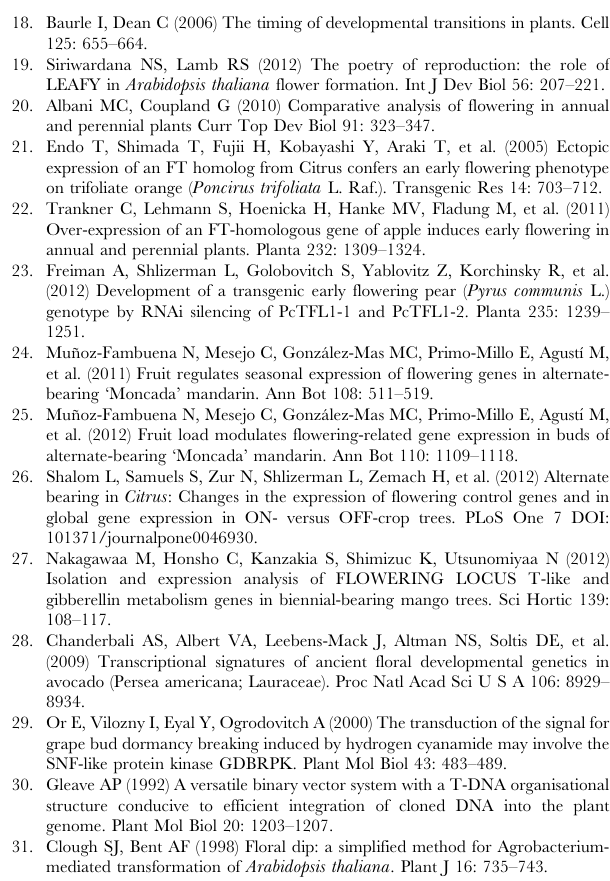
(TIF) Figure S2 Phylogeny of FT, TSF, MFT, TFL and BFT proteins. Conserved amino acid sequences of Persea american FT protein (boxed) and FT, TSF, MFT, TFL and BFT proteins from various plant species were compared using the CLUSTALW multiple alignment program. The phylogenetic tree was con- structed using the Neighbor-Joining method (http://www. genome.jp). Database accession numbers are given in parenthesis. (TIF) Figure S3 The increase in PaFT mRNA levels correlates with a decrease in temperature levels . Minimal and maximal temperatures recorded from mid-August until the beginning of March at the Tel Mond stiation near kibbutz Eyal, where experimental ‘Hass’ trees were grown ( A ). The arrow denotes the initial date when the minimal temperature dropped below 15 u C. Seasonal expression profiles of PaFT in leaves from fully loaded ( on ) and completely de-fruited ( off ) ‘Hass’ trees are shown. Off trees correspond to trees from which fruit load was completely removed in July ( B ). Data are means 6 SE of three independent replicates (n= 3 trees).